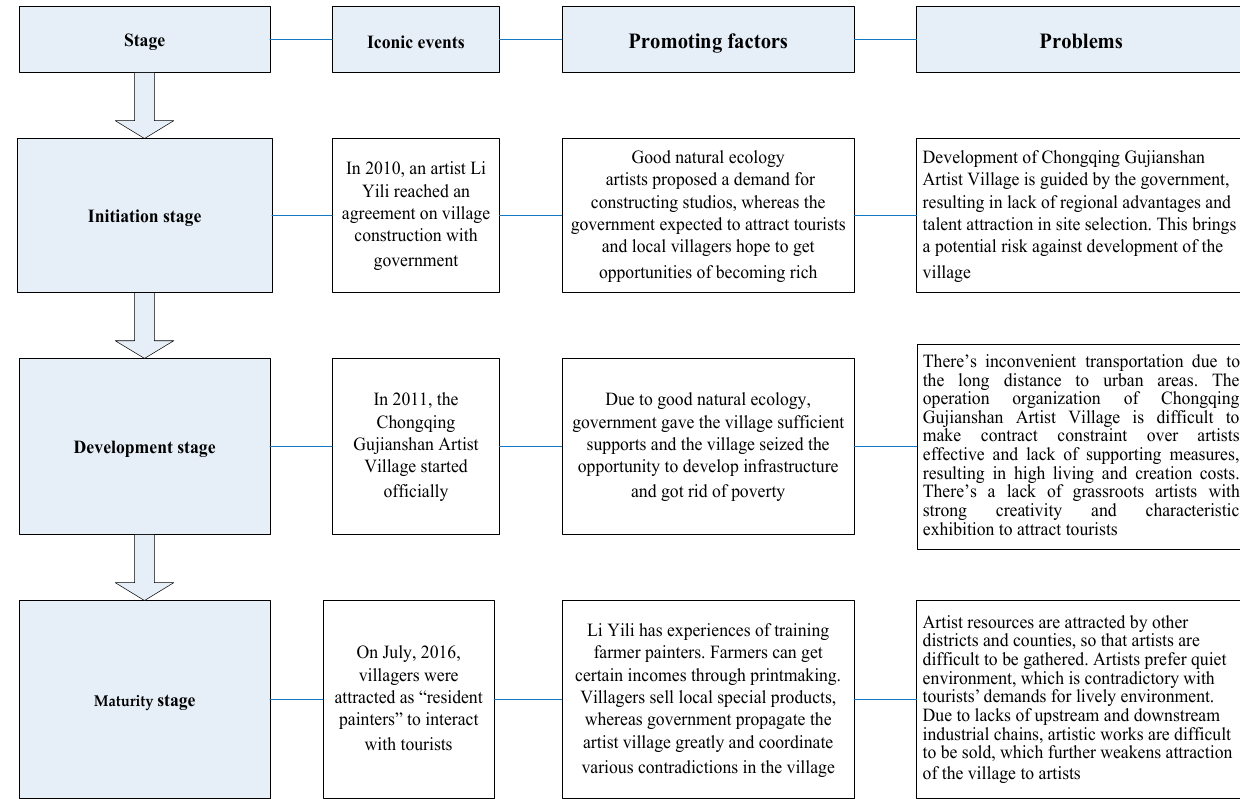
Figure 4. Development path of Chongqing Gujianshan Artist Village.